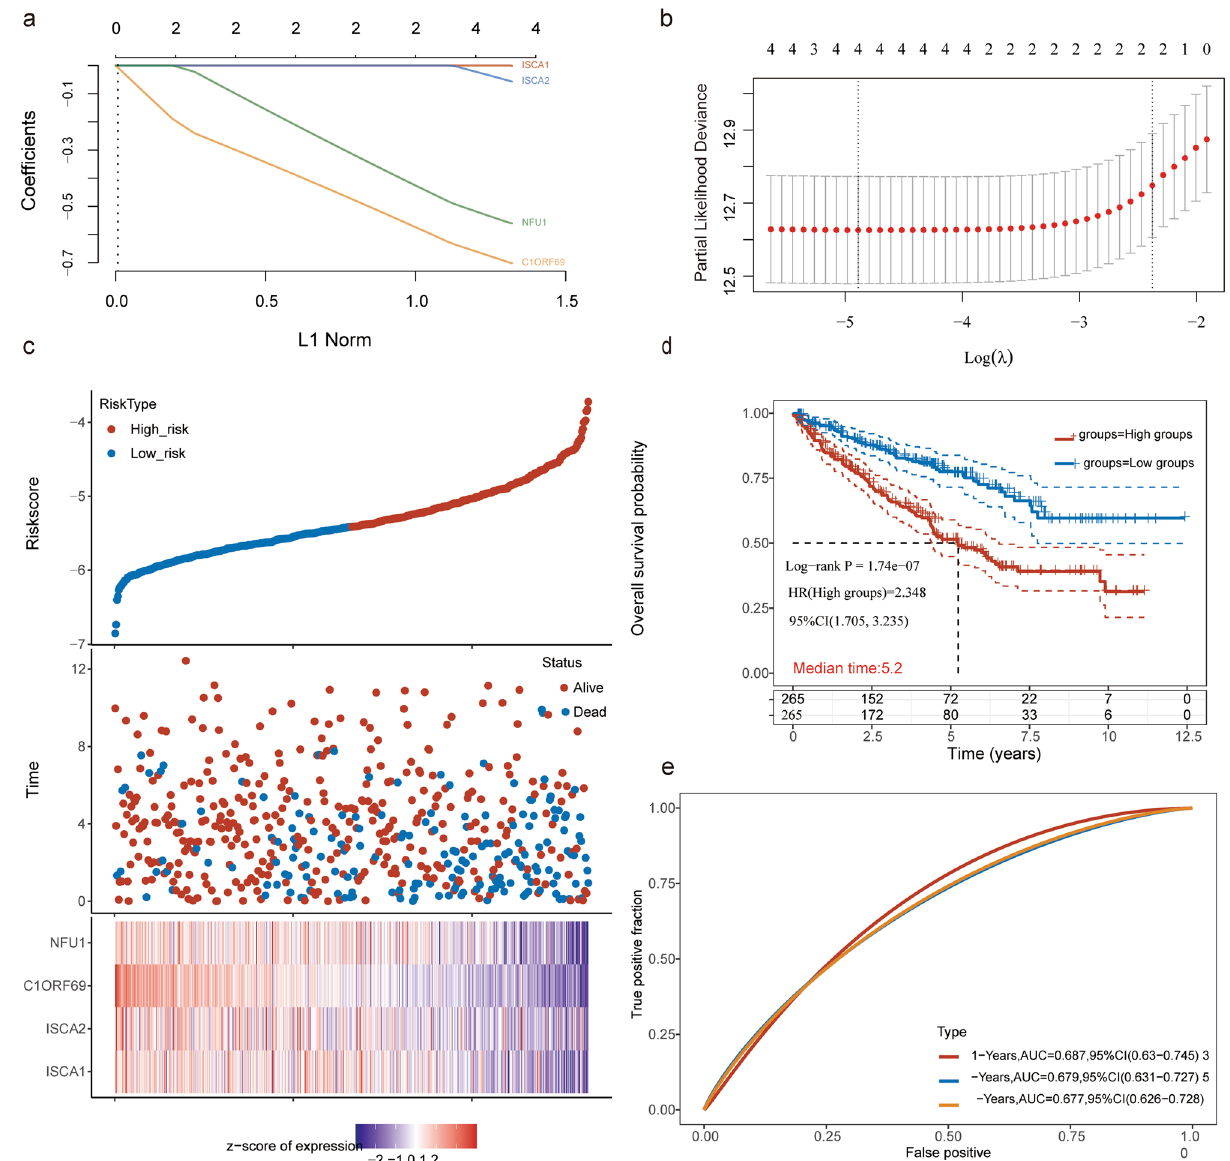
Figure 5. Construction and validation of the 4-gene signature based on the MMDS related iron–sulfur protein genes. ( a ) The changing trajectory of each independent variable. ( b ) The confidence interval under each lambda. ( c ) Construction of risk model and distributions. ( d ) The KM survival curve distribution of the 4-gene signature in all TCGA datasets. ( e ) The 1-year, 3-year and 5-year ROC of the